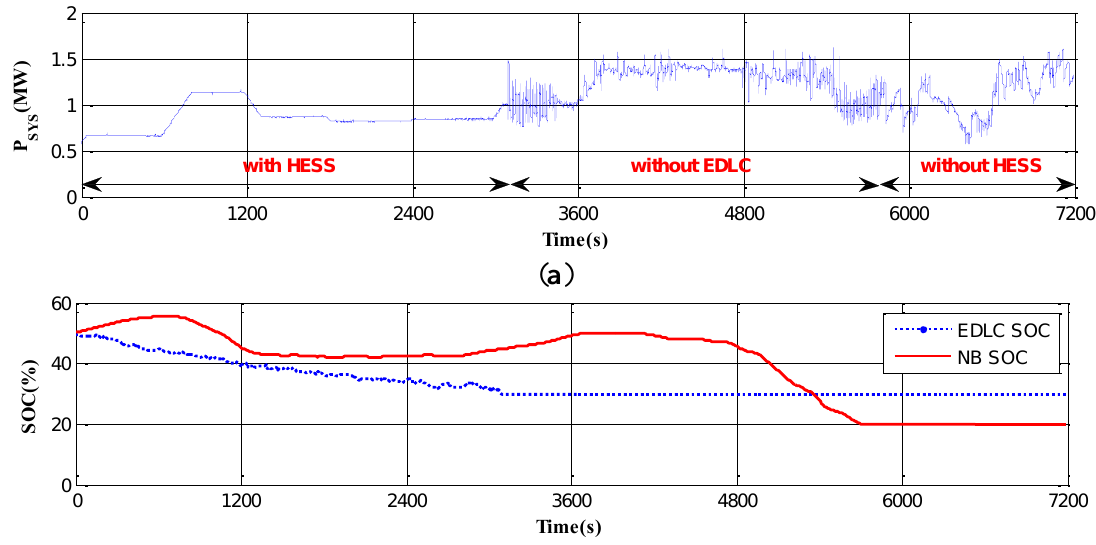
Figure 10. Simulation results for Case 1—without SOC control strategy: ( a ) total system power output; and ( b ) SOC level of EDLC and